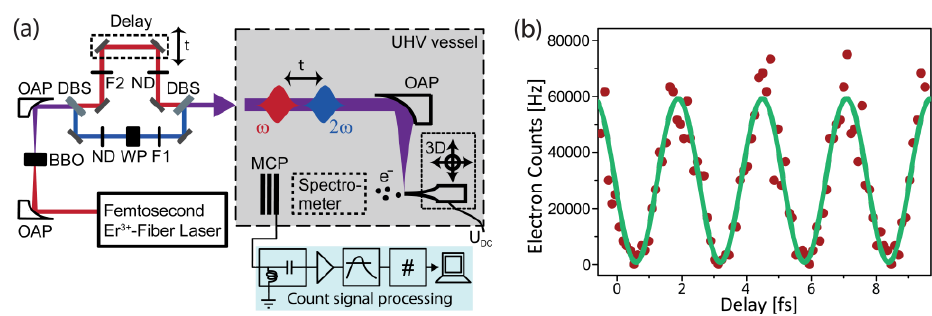
Fig. 1. (a) Experimental setup for two-color photoemission. Femtosecond laser pulses from an Erbium-doped fiber laser and its second harmonic are focused onto the nanotip to trigger two-color phase-controlled photoemission. (b) Electron count rate dependent on time delay τ or, equivalently optical two-color phase ϕ . 97.5% count rate modulation is achieved upon change of the optical phase between the two